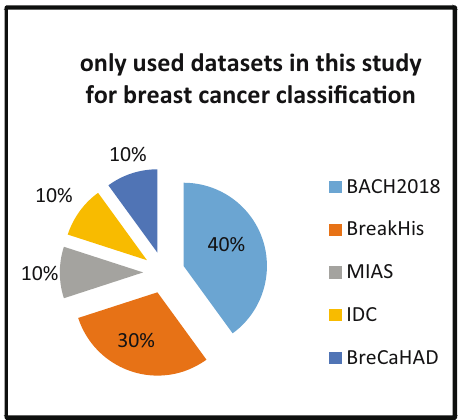
Figure 12: Most commonly used datasets in this study for breast cancer classi fi